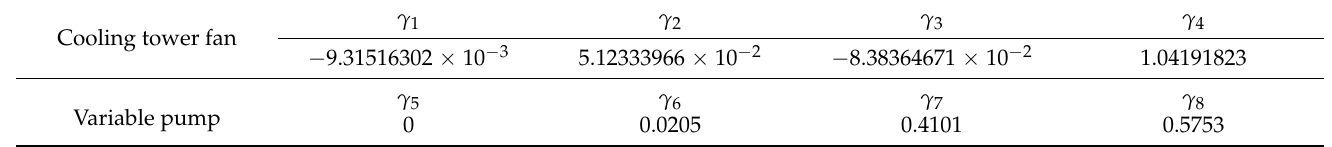
Table 6. Variable-speed fan and pump coefficients.